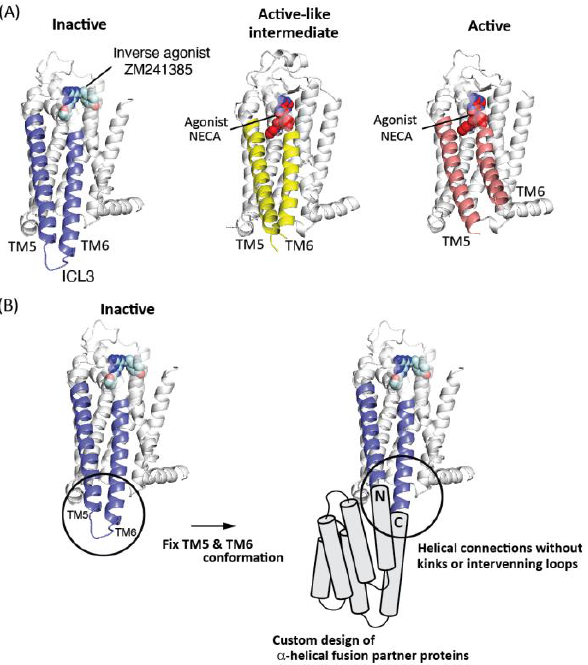
Figure 1. Strategy for state-targeting stabilization of GPCR, using de novo designed fusion partner proteins. ( A ) Multiple conformational states of A 2A R. From left, the presented structures, respectively, correspond to the ones in an inactive, active-like intermediate, and activate states (PDB ID: 3PWH, 2YDV, and 5G53, respectively) [22,24,25]. The structure in the inactive state binds to the inverse agonist ZM241385, and the structures in the active-like intermediate, and active states bind to the agonist NECA. ZM241385 and NECA are shown in a sphere model. TM5 and TM6 are colored in blue for the inactive state, yellow for the active-like intermediate state, and pink for the active state. The loop connecting TM5 and TM6 is called ICL3. TM6 with TM5 exhibits large conformational changes upon the state transitions. ( B ) Our strategy for the state-targeting stabilization of A 2A R. We fix the TM5 and TM6 conformation in a targeted state through the fusion strategy. To this end, we design α -helical proteins, which can be fused into A 2A R in the targeted state through straight helical connections without kinks or intervening loops. In this work, we tested this idea by stabilizing the inactive